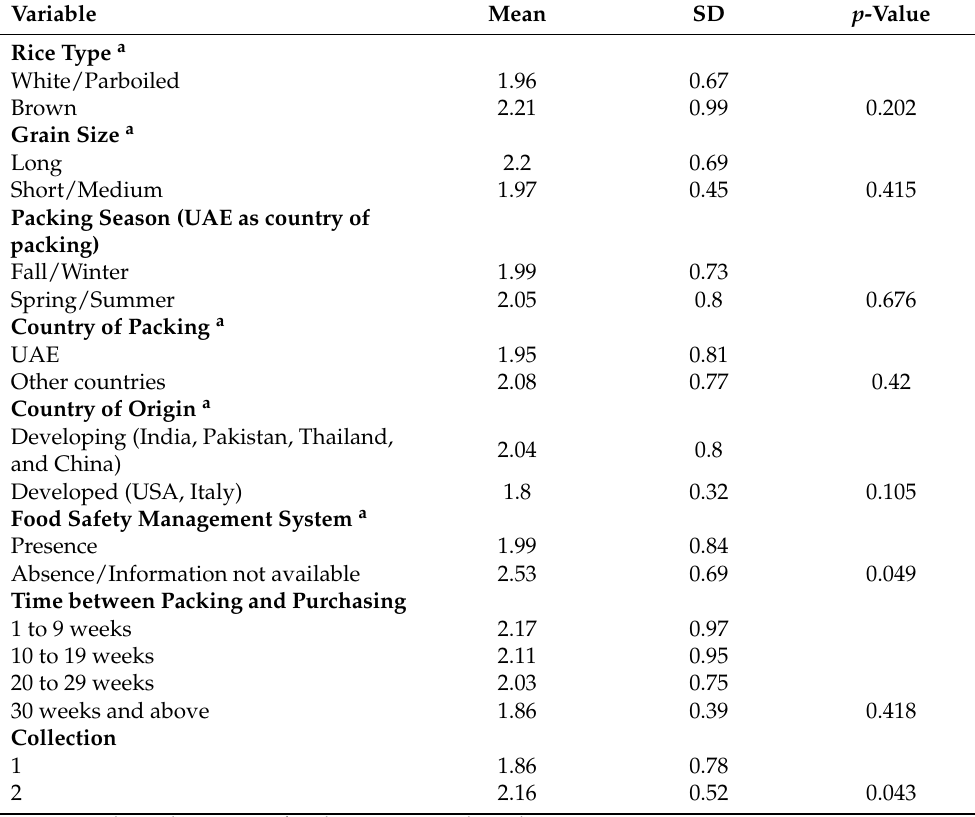
Table 2. Effect of different independent variables on mean ( µ g/kg) AFB1 levels in rice samples.